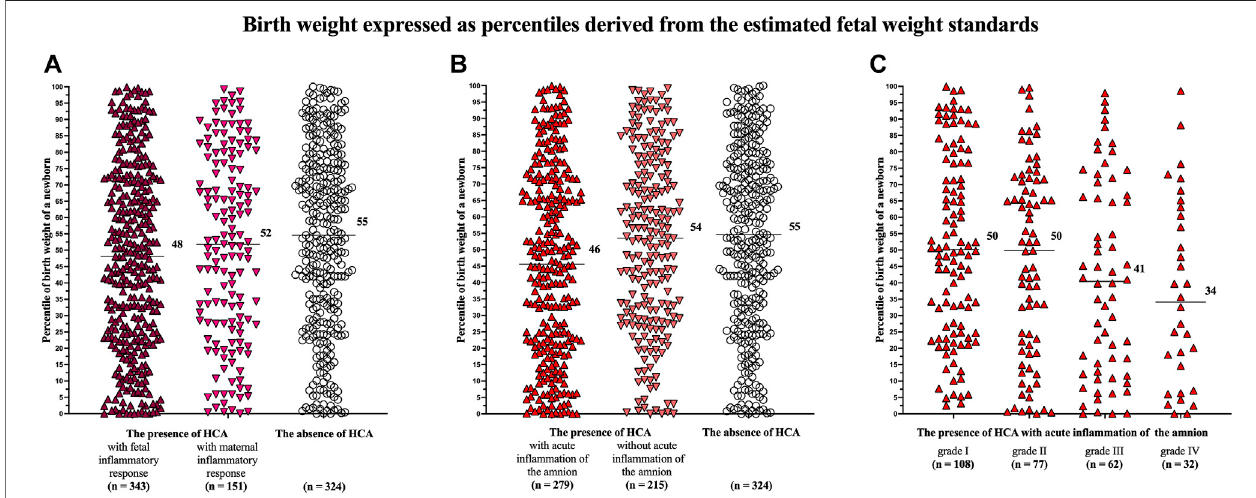
FIGURE1| Comparison ofthebirthweightsofnewborns,expressed aspercentilesderivedfromtheestimated fetalweightstandards,amongthewomenwiththe presenceofHCAwithfetalandmaternalin fl ammatoryresponsesandthosewiththeabsenceofHCA (A) ;amongthewomenwiththepresenceofHCAwithand without acute in fl ammation of the amnion and those with the absence ofHCA (B) ; and among the women with ofacute in fl ammation of the amnion divided based on its severity (grades I – IV) (C) . A difference was observed among the women with the presence of HCA with fetal and maternal in fl ammatory responses and those with the absence of HCA only in the crude analysis ( p = 0.02) but not in the adjusted analysis ( p = 0.14) (A) . A difference was observed among the women with the presence of HCA with and without acute in fl ammation and those with the absence of HCA in both the crude and adjusted analyses ( p = 0.004, p = 0.02) (B) . A difference was